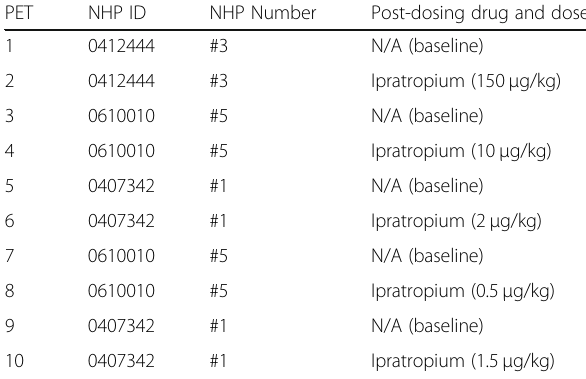
Table 2 PET measurements in panel 2. Drug delivery